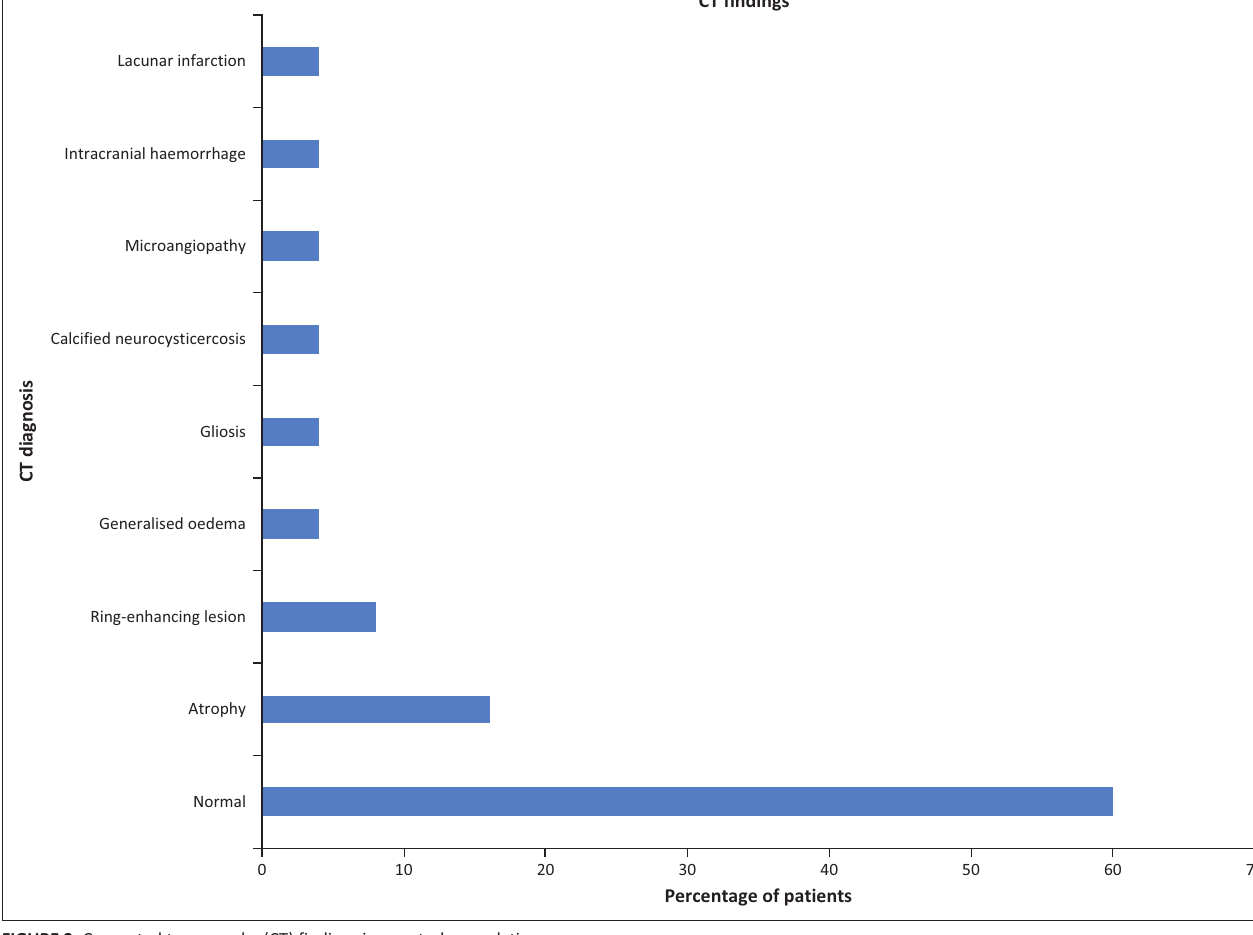
FIGURE 2: Computed tomography (CT) findings in our study